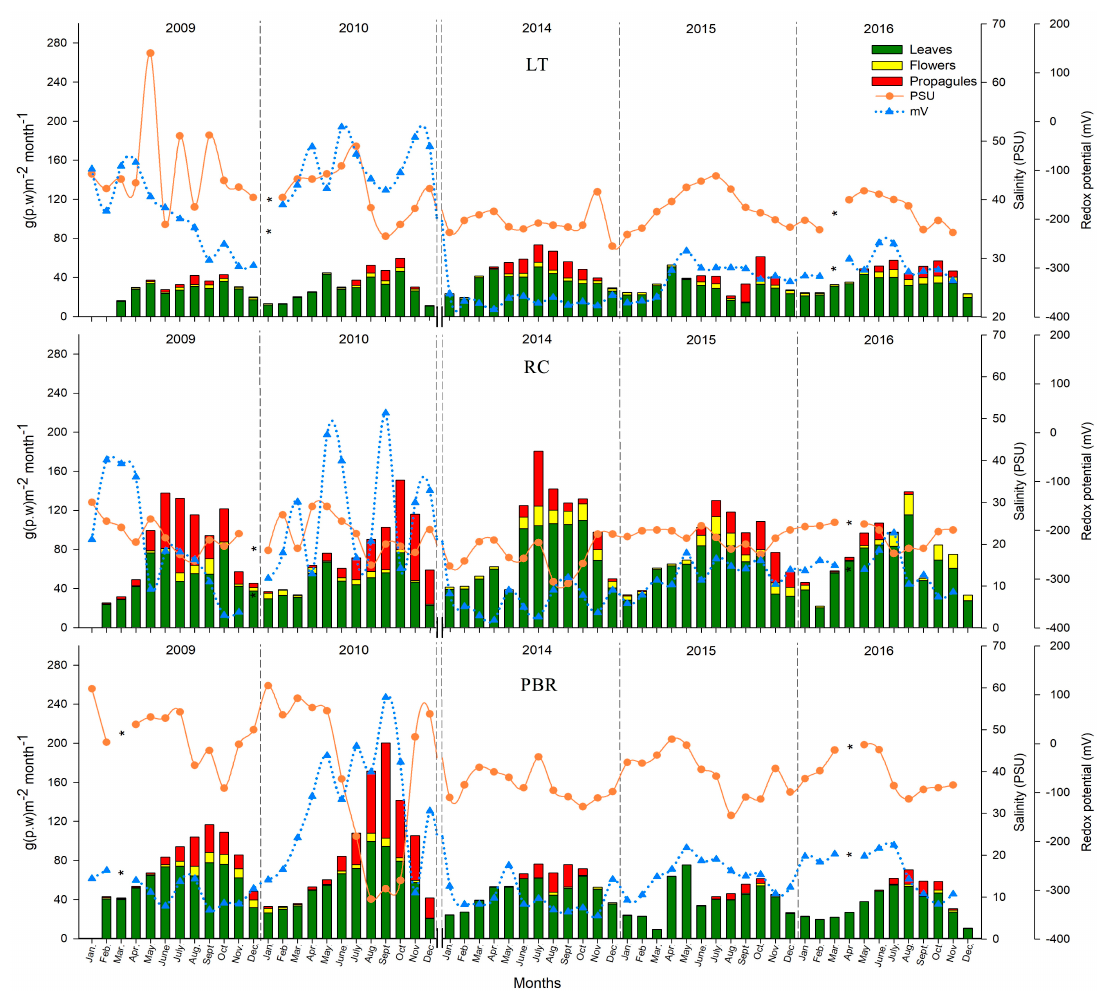
Figure 5. Reproductive phenology based on litterfall in seven mangrove forests along the coast of Campeche, México from 2009 to 2010 and 2014 to 2016. The southern region includes Laguna de Terminos, and the northern region includes Rio Champoton and the Los Petenes Biosphere Reserve.